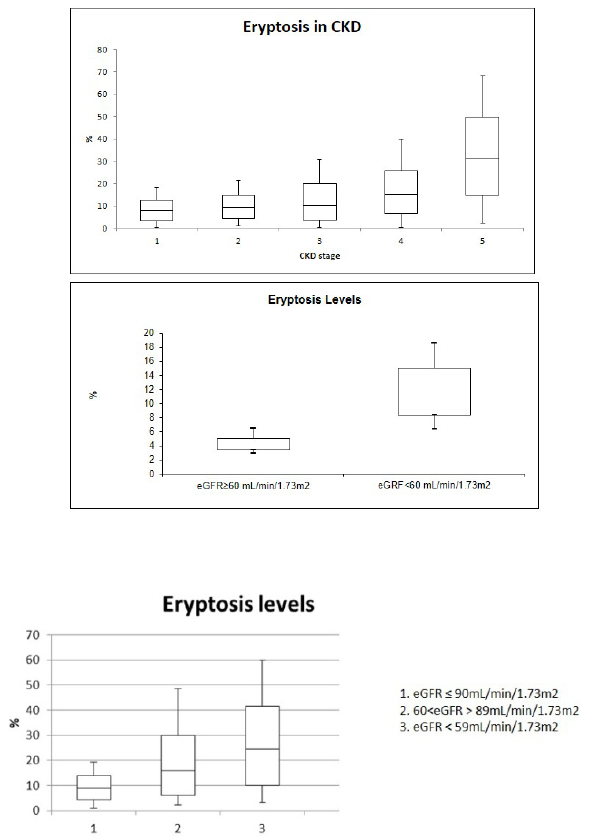
Figure 1. Eryptosis levels increase with worsening of Chronic Kidney Disease.